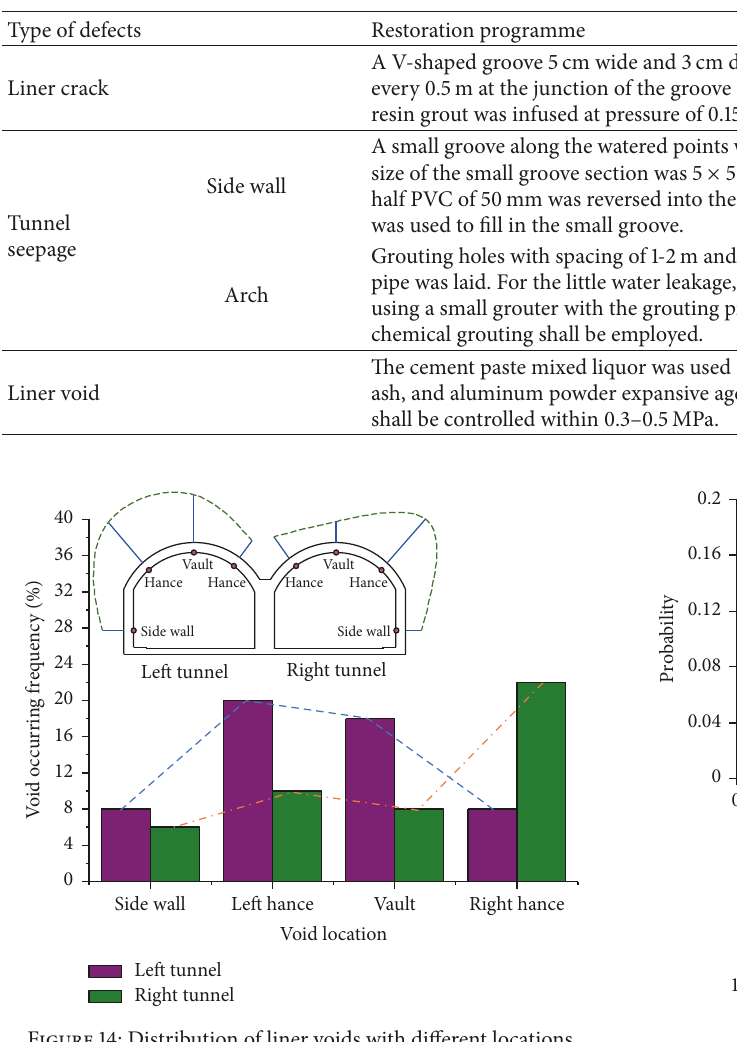
Figure 14: Distribution of liner voids with different locations.